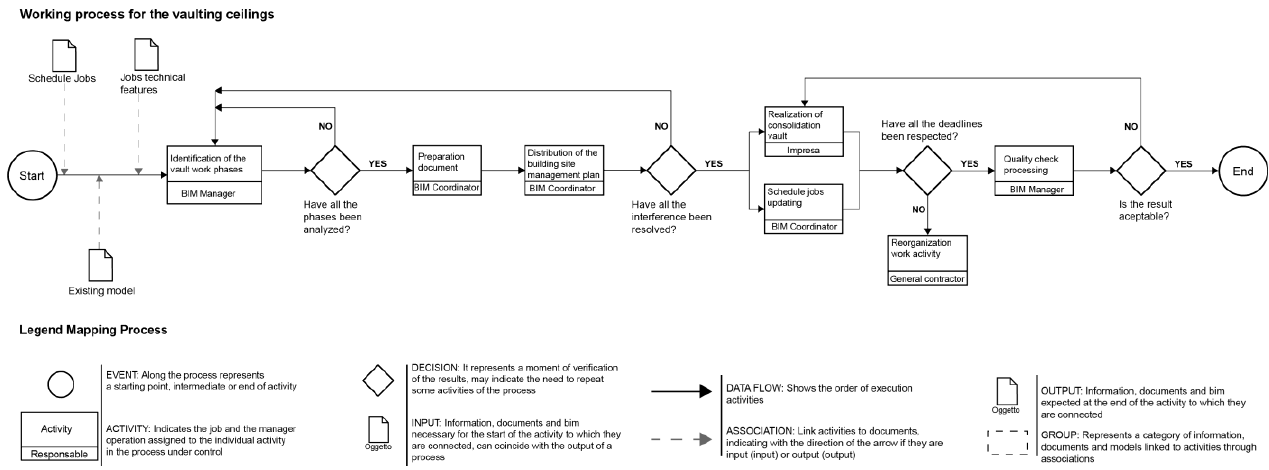
Figure 4: BEP consolidation of the vault.